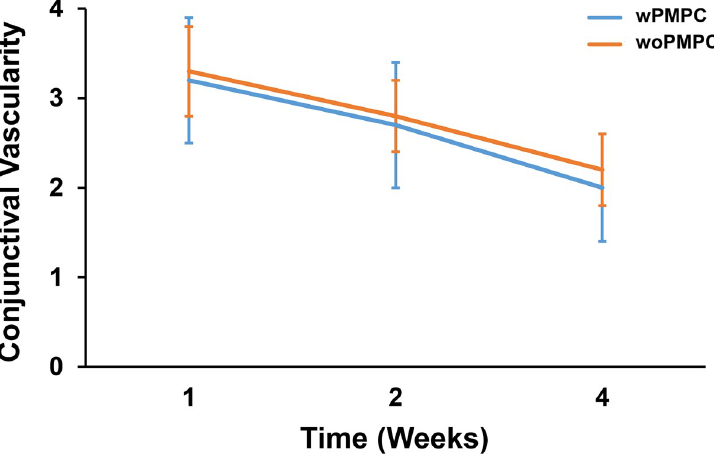
Fig 4. Comparison of gross conjunctival vascularity. Quantification of overall conjunctival vascularity using the Indiana Bleb Appearance Grading Scale. There were no significant differences between the two groups at weeks 1, 2, and 4 after surgery (p = 0.715, 0.523, 0.598, respectively). Data are shown as the mean ± standard deviation for each group. wPMPC, Ahmed glaucoma valve coated with PMPC; woPMPC, Ahmed glaucoma valve without PMPC- coating.